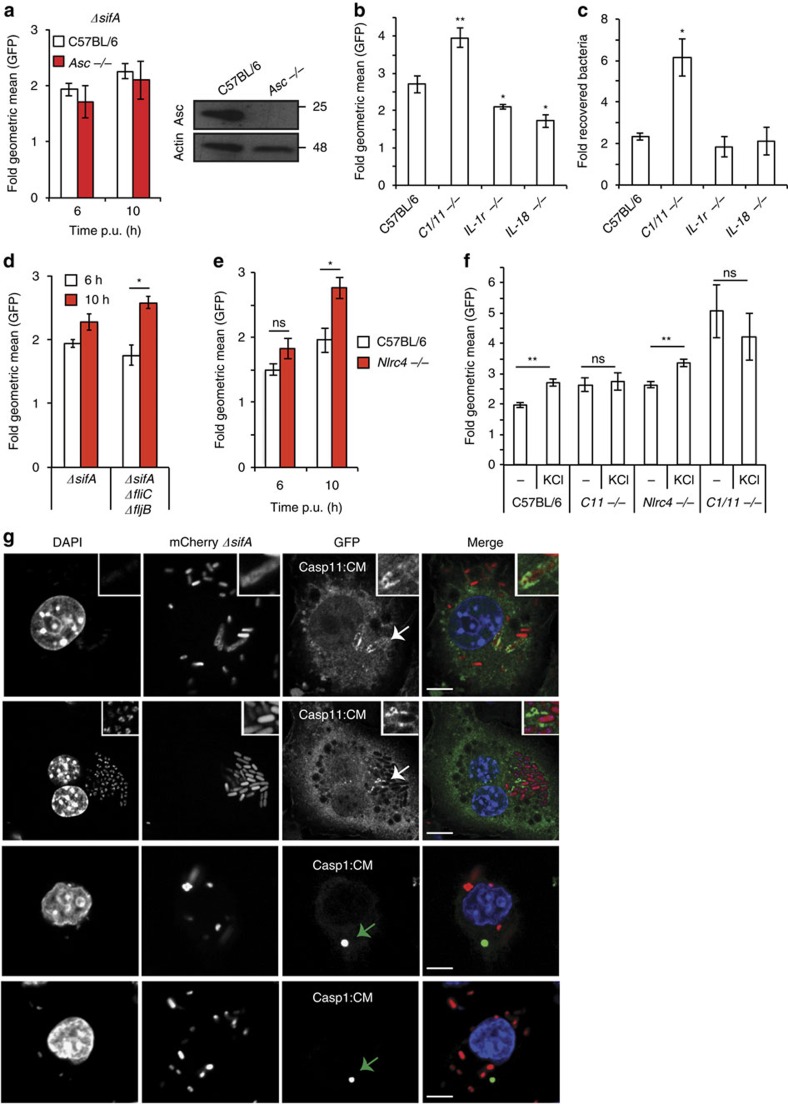
Growth inhibition of ΔsifA does not require cytokine production.(a,b) Flow cytometry analysis of GFP fluorescence per PI-negative cell of the indicated genotype after infection with GFP-ΔsifA Salmonella, expressed as fold geometric mean from 2 h. Inset immunoblot for ASC and Actin from the indicated cell lines. (c) Fold recovery in ΔsifA bacterial CFU at 17 h p.u., normalized to 1 h p.u., from the indicated cell lines. (d,e) Flow cytometry analysis of GFP fluorescence in the indicated iBMDMs infected with the GFP-expressing bacterial strains expressed as fold geometric mean from 2 h. (f) The indicated cell lines were treated with solvent control or KCl and bacterial replication (10 h/2 h) of GFP-ΔsifA Salmonella was determined by flow cytometry analysis of GFP fluorescence per PI-negative cell. (g) Confocal microscopy images of fixed Casp1/11−/− iBMDMs expressing GFP-tagged catalytic mutants (CM) of caspase-1 (Casp1:CM) or caspase-11 (Casp11:CM) and infected with mCherry-expressing ΔsifA Salmonella for 8 h. DAPI (4′,6-Diamidino-2-Phenylindole, Dihydrochloride) was added to label DNA (blue). White arrows—enlarged boxed area. Green arrows—speck. Mean and s.e.m. of at least three independent repeats (a–f) or from two representative experiments (g). Student's t-test, *P<0.05, **P<0.01. Scale bar, 5 μM.